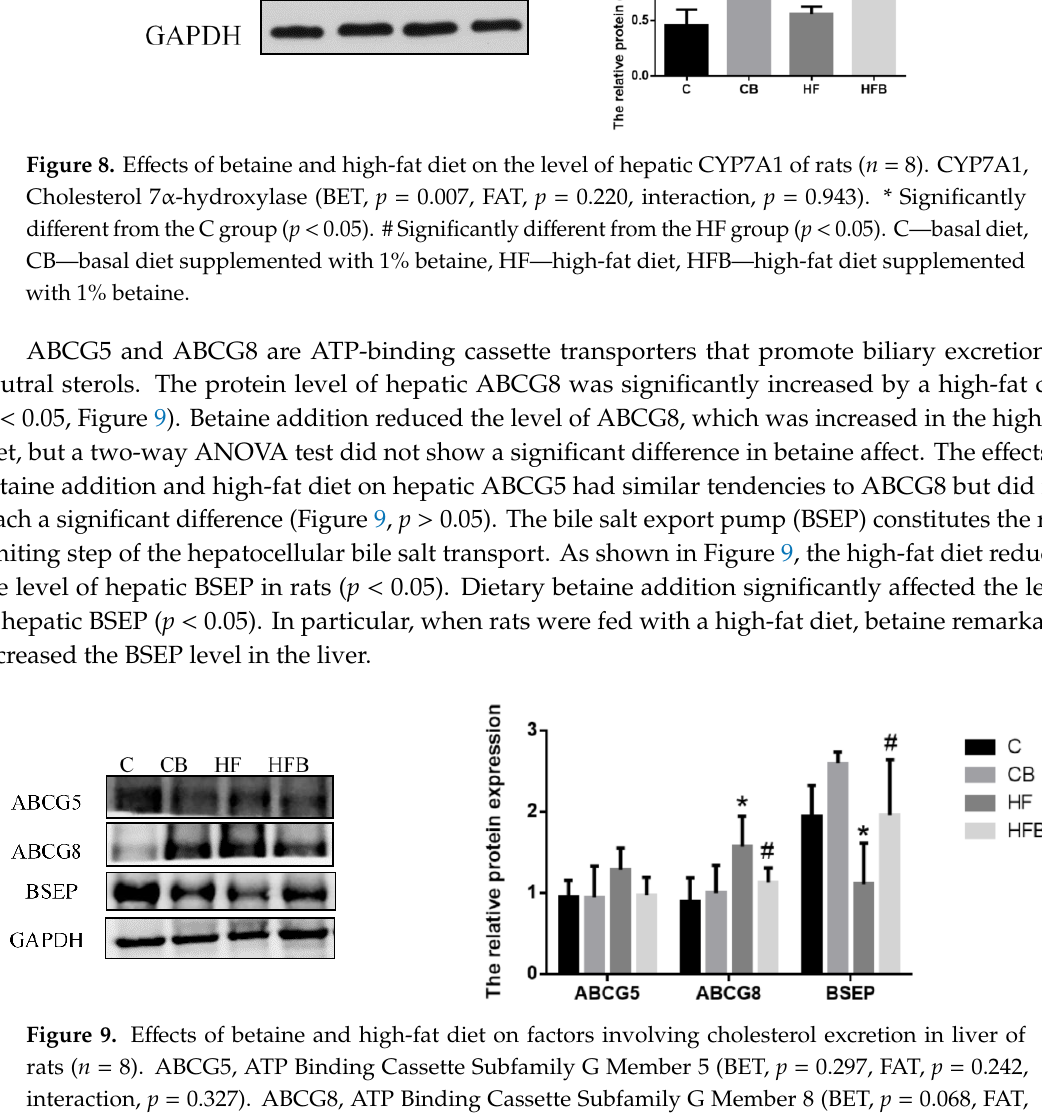
Figure 10. Effects of betaine and high-fat diet on total bile acid in intestine of rats ( n = 8). Two-way ANOVA: BET, p = 0.041, FAT, p = 0.211, interaction, p = 0.143. C—basal diet, CB—basal diet supplemented with 1% betaine, HF—high-fat diet, HFB—high-fat diet supplemented with 1% betaine. # Significantly different from the HF group ( p < 0.05). 3.5. Cholesterol of Hepatocyte In Vitro In order to further investigate the effects of betaine addition on cholesterol metabolism in hepatocytes, we carried out the experiment on hepatocytes in vitro. As shown in Figure 11, there was a significant difference of cholesterol level in HepG2 cells affected by betaine or high-fat medium ( p < 0.05). As for BRL3A cells, betaine addition or high-fat medium also showed a significant effect on the cholesterol level ( p < 0.05). Additionally, betaine addition decreased the level of cholesterol in BRL3A, which was increased by the high-fat medium.